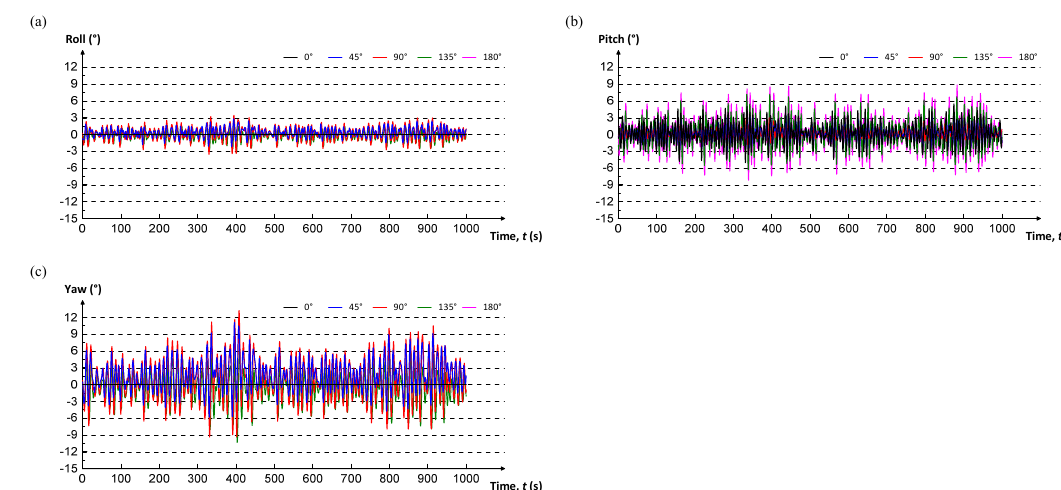
Figure 22. Rotational responses against different approaching wave directions under storm wave conditions. ( a ) Roll; ( b ) Pitch; ( c ) Yaw. Duct is 25 m below sea surface.